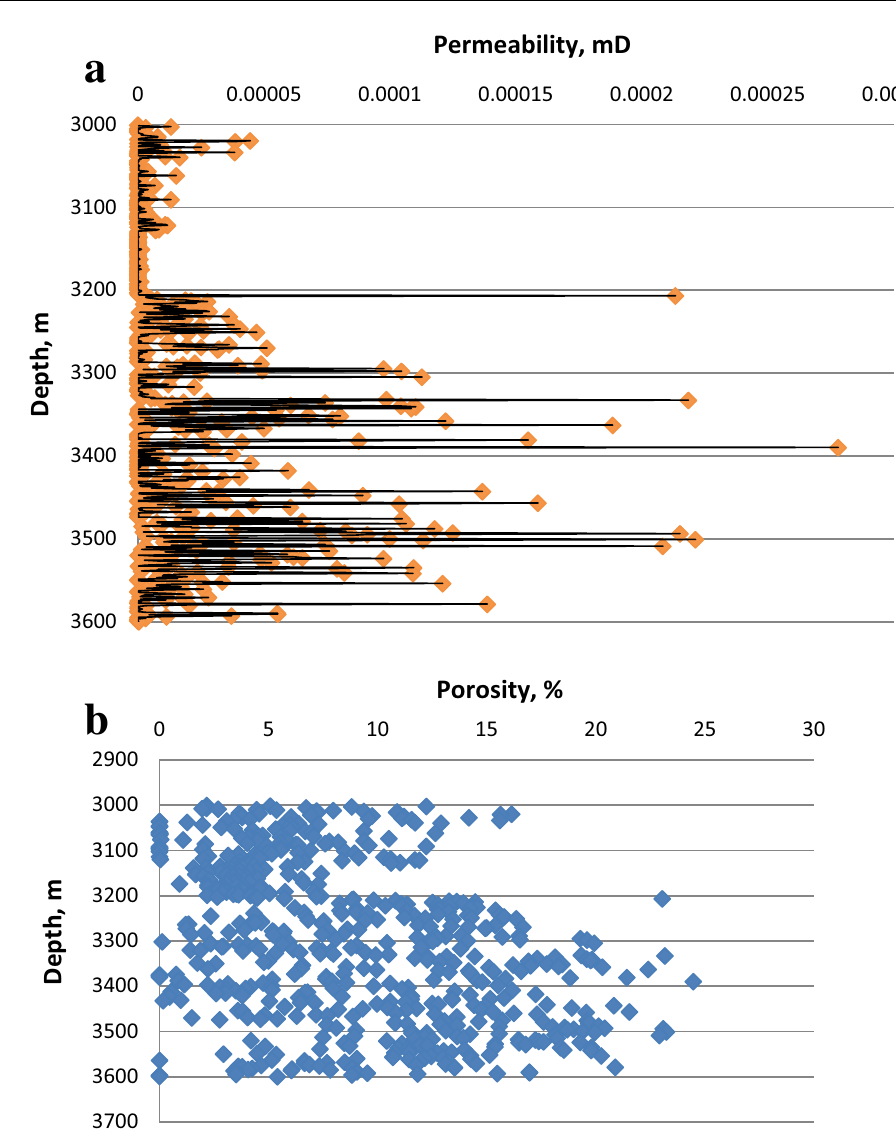
Fig. 16 a Depth–permeability cross-plot of Penek Formation.